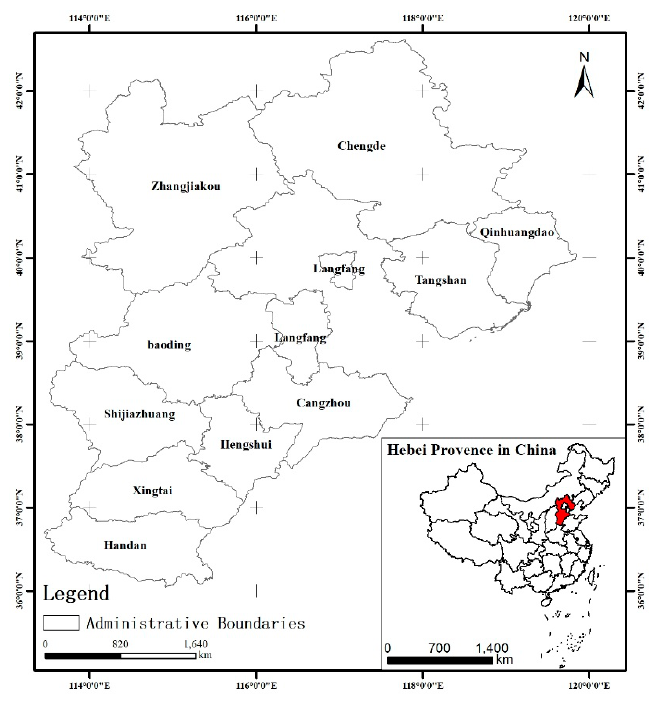
Figure 1 . Location of Hebei Province . Figure 1. Location of Hebei